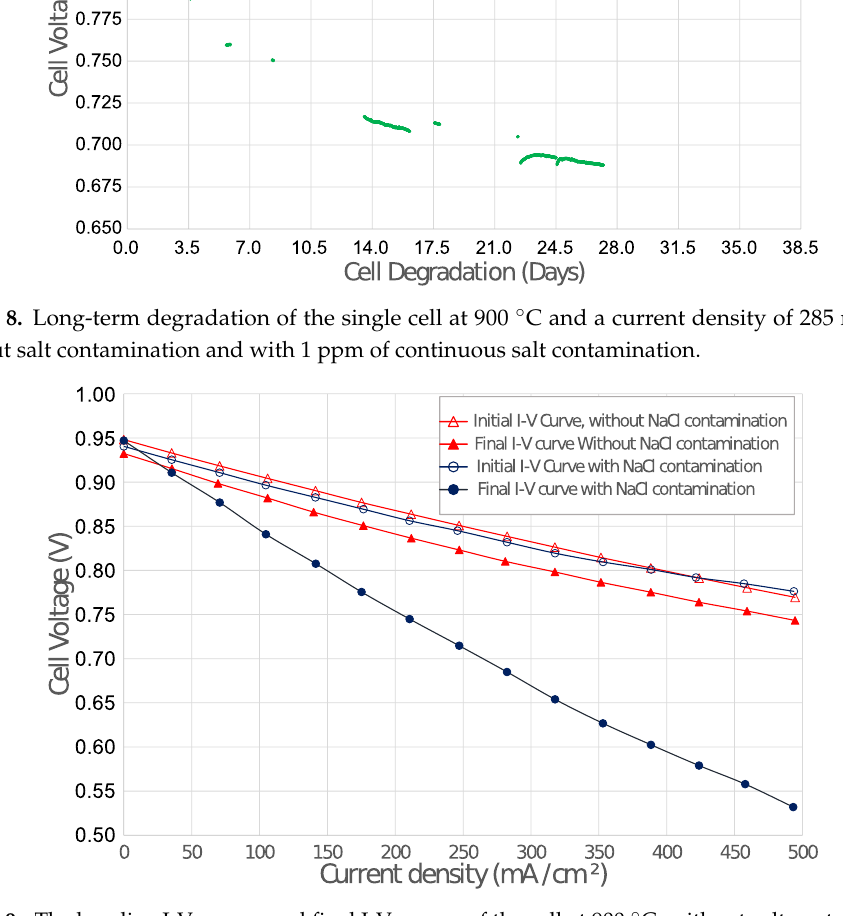
Figure 9. The baseline I-V curves and final I-V curves of the cell at 900 ◦ C, without salt contamination for 850 h and with salt contamination of 1 ppm for 660